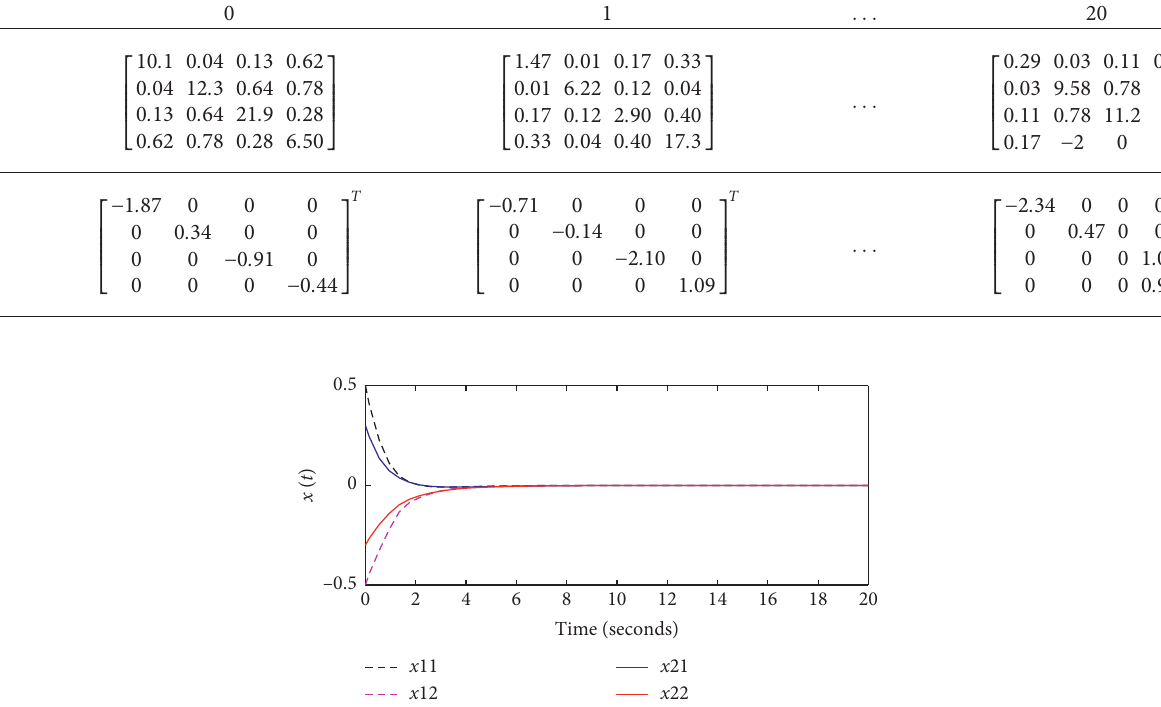
Table 1: The control parameters K and Λ .